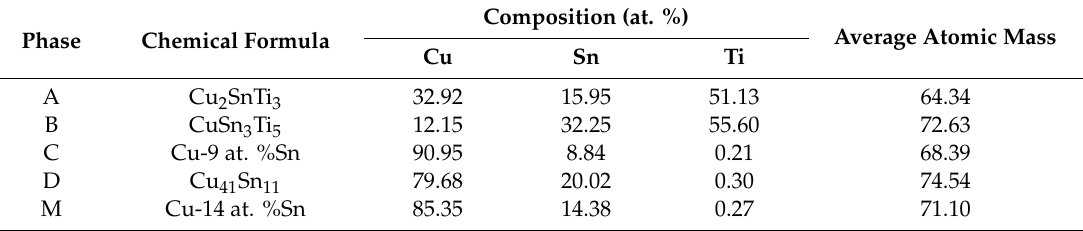
Table 1. The chemical formula and composition of the Phases A, B, C, D, and M in the Cu-23 at. %Ti–17 at. %Sn alloy.